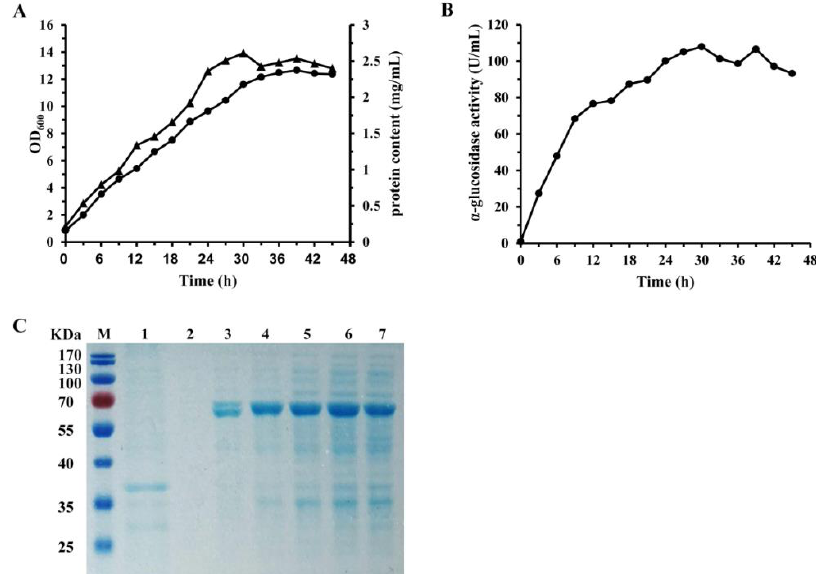
Figure 1. Recombinant α -glucosidase (GSJ) production from E. coli BL21 (DE3). ( A ) Time profiles for batch cultivations of recombinant E. coli in shake flasks: ●, OD600 of the bacteria cells; ▲ , the protein concentration of recombinant GSJ. ( B ) The intracellular enzyme activity of recombinant GSJ. ( C ) Sodium dodecyl sulfate-polyacrylamide gel electrophoresis (SDS-PAGE) analysis of recombinant GSJ. Samples were run on a 10% SDS-PAGE gel. Proteins were visualized using Coomassie Brilliant Blue G-250. Lane M, molecular weight markers; Lane 1, E. coli BL21-pET28a; Lane 2-7, intracellular supernatant of recombinant E. coli after isopropyl β -D-1-thiogalactopyranoside (IPTG) induction at 0 h, 6 h, 12 h, 21 h, 27 h and 33 h. Molecules 2019 , 24 , x FOR PEER REVIEW